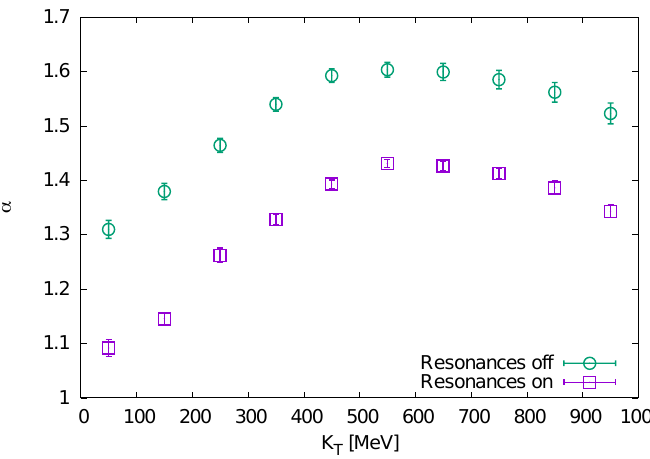
Figure 2. The Lévy parameter α of the 1D fits to the correlation function in q inv . The result from the fits to the correlation function from a source without resonances (green circles) and with resonances (purple squares). Vertical error bars show the 1 σ